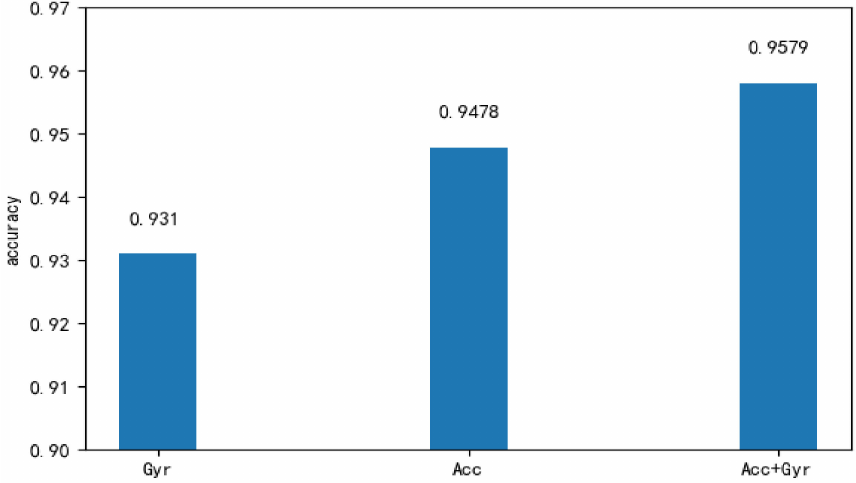
Figure 6. Accuracy comparison of using sensors fusion or not. Gyr represents using gyroscope alone, and Acc represents using accelerometer alone, and Acc + Gyr means the fusion of